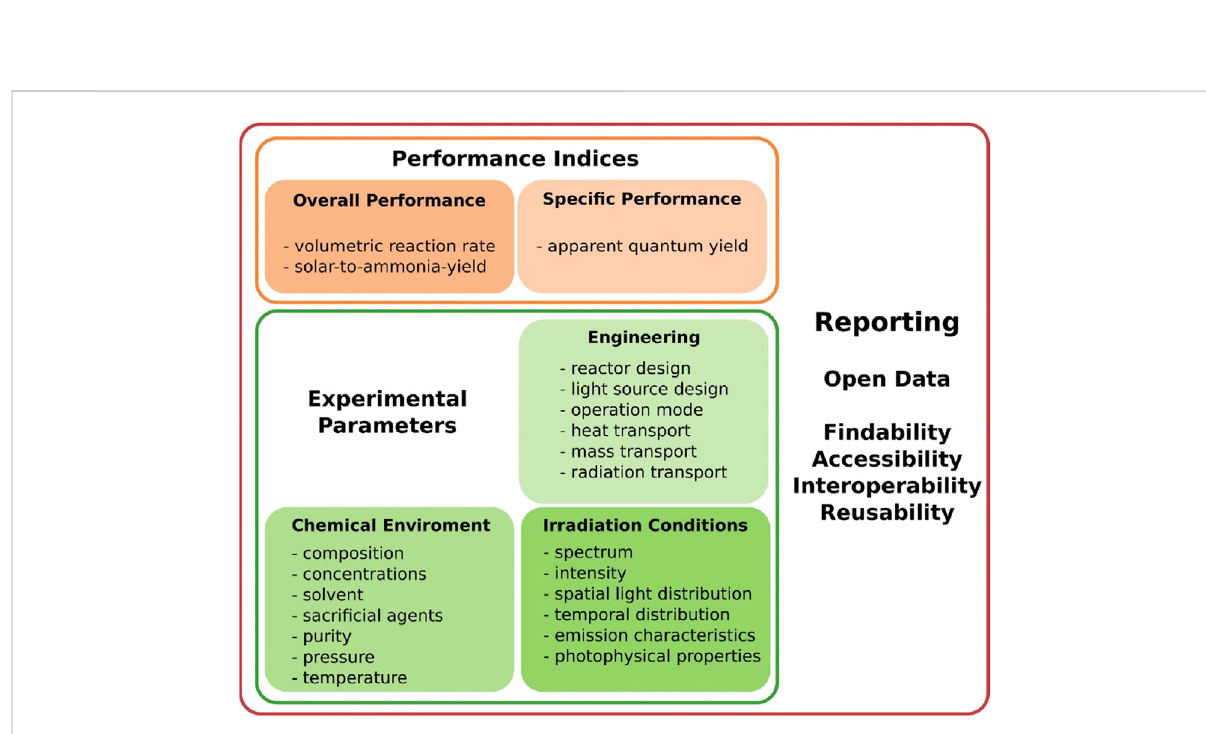
FIGURE 4 Guidelines for experiment normalization to rule out the impact of various parameters that in fl uence the overall and speci fi c performance indices. Reproduced from ref. (Ziegenbalg et al., 2021). With permission from the John Wiley and Sons.